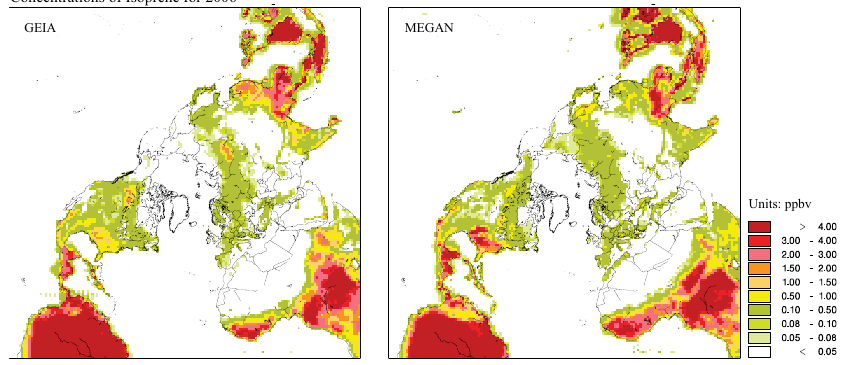
Fig. 8. Annual isoprene concentrations (ppbV) simulated by DEHM in the lowest model layer (with thickness of 12 m) using the MEGAN and GEIA biogenic emission